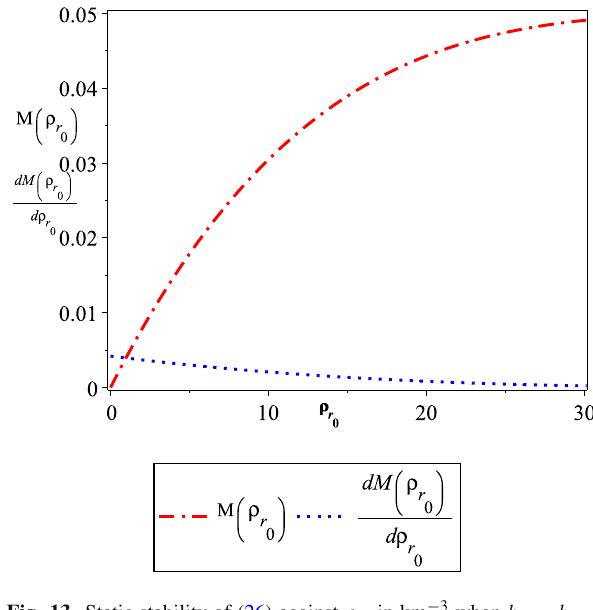
in km − 3 when b 0 = b 2 = 0